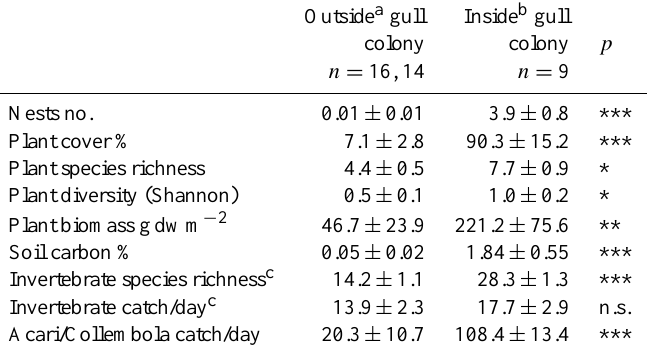
Table 2. Surtsey permanent plot data. Average density of gull nests in plots on Surtsey, 2003–2012 (no. /1000m 2 ) , plant cover, species richness and diversity of vascular plants in 2012, standing biomass of vascular plants (live and dead) in 2011, and total carbon in top 10cm of soil in 2008. Invertebrate and Acari/Collembola data are pitfall traps averages for the 2002–2006 sampling seasons, catch data are individuals caught. Means ± s.e.; p = ANOVA level of significance, n.s. = >0.05; * =≤ 0.05: ** =≤ 0.01; *** =≤ 0.001. a Plots 11–22, 29–32; b plots 1, 3, 4, 6–10, 23; c include Coleoptera, Diptera, Hemiptera, Hymenoptera, Lepidoptera, Neuroptera, Thysanoptera, Araneae, Gastropoda and Oligochaeta. Invertebrates (including Acari/Collembola) were not sampled in plots 31 and 32, n = 14. Outside a gull Inside b gull colony colony Nests no.